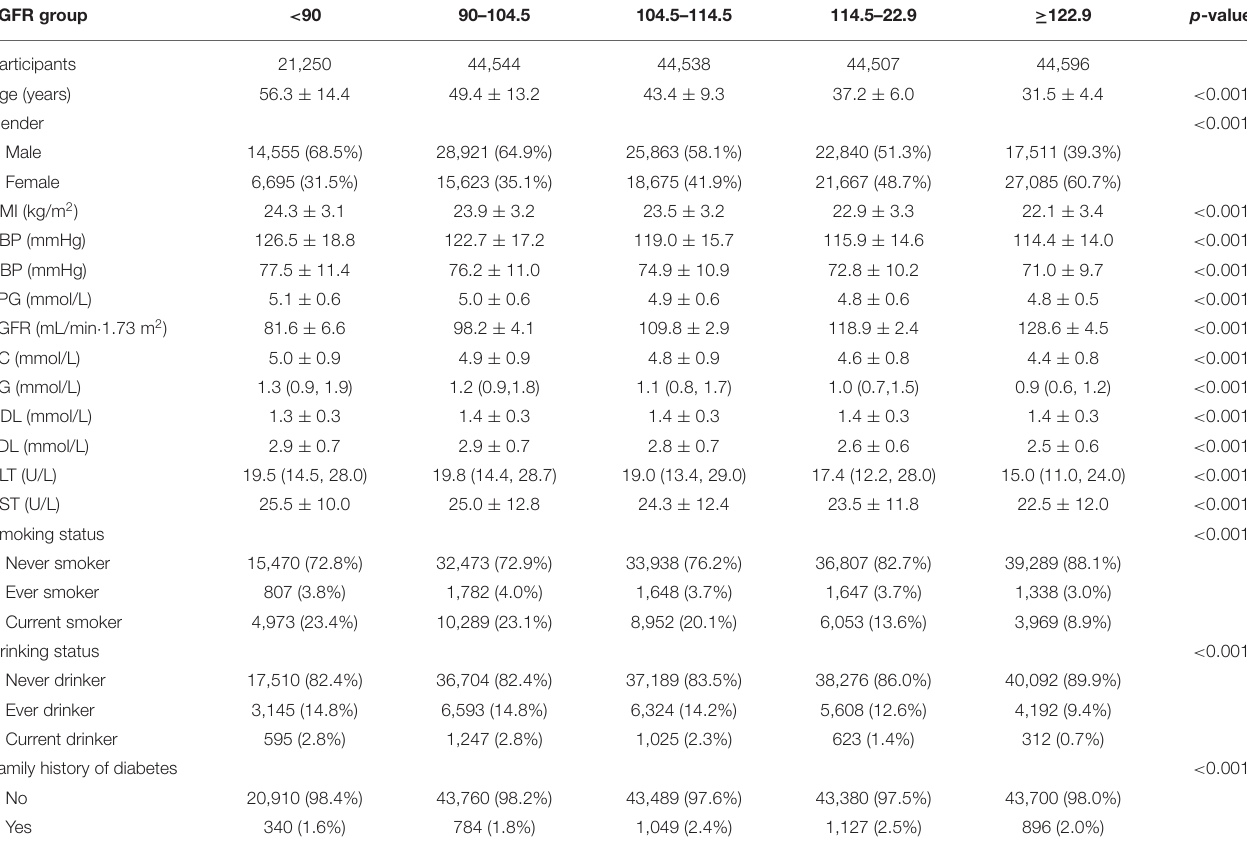
TABLE 1 | The baseline characteristics of